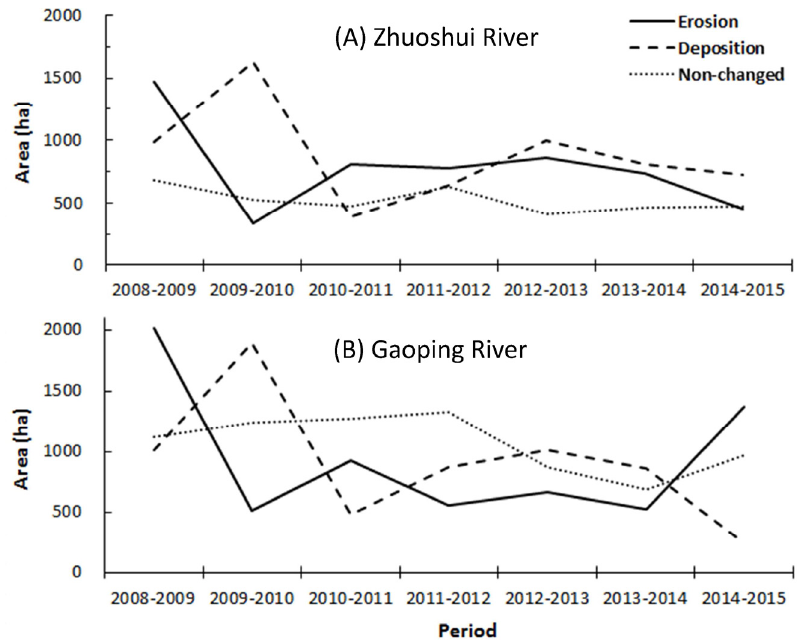
Figure 5. The annual changes for erosion, deposition and non-changed areas in the Zhuoshui River ( A ); and the Gaoping River ( B ). Water 2017 , 9 , 84